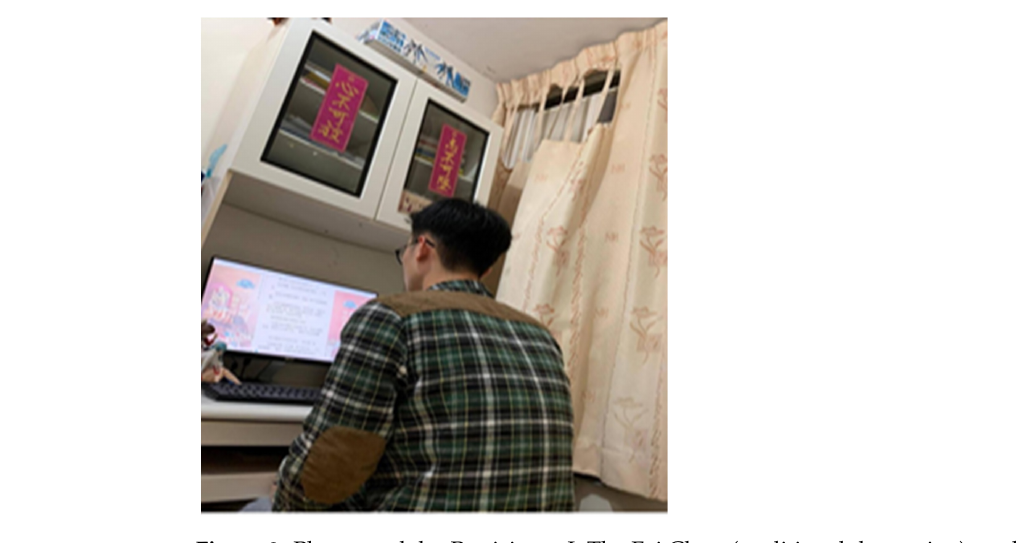
Figure 9. Photograph by Participant J. The Fai Chun (traditional decoration) on the bookshelf are “High but not falling, Heart but not losing”. “I wanted to talk with him more and to understand him. … I was uncertain whether he was in class or doing homework. He looked happy but it is not good to spend a long time on the phone.” (Participant J)